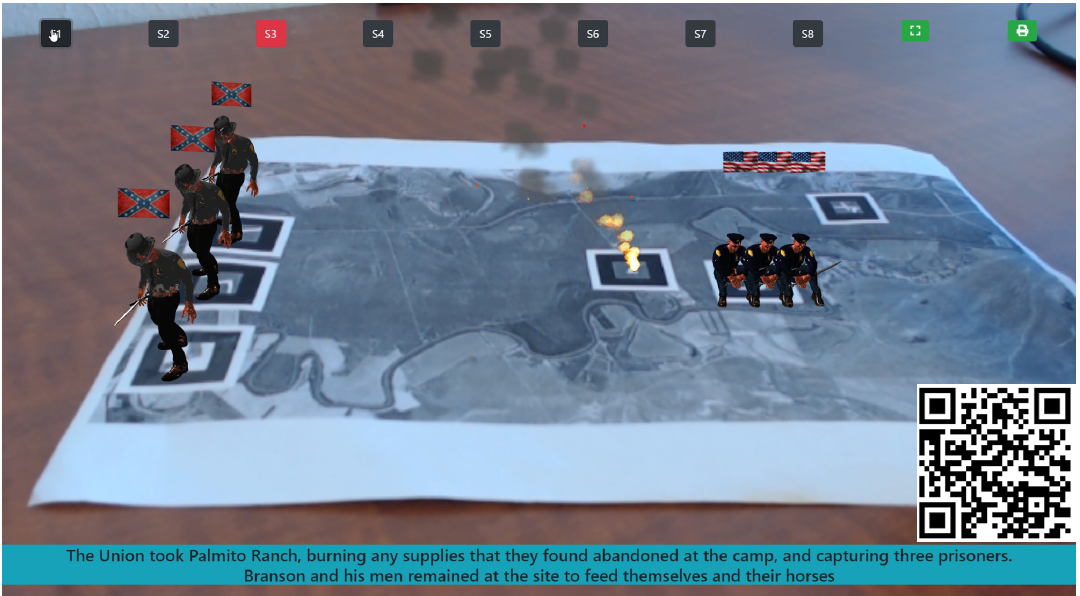
Figure 3. Main AR scene of Palmito Ranch Battlefield. QR code located at the bottom right allows users to access the Augmented Reality (AR) application. Stage 3 is being simulated (red color button), with the annotated text describing the event as Union forces taking the Palmito Ranch and burning the